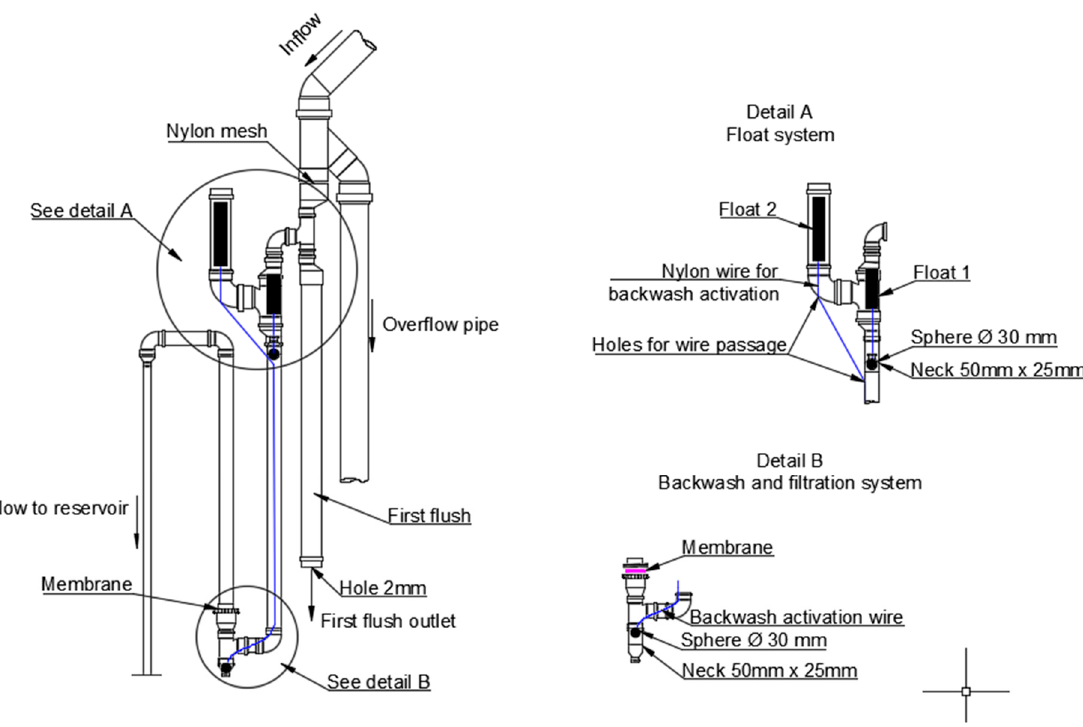
Figure 4. Schematic showing the assembly of the membrane filter system.